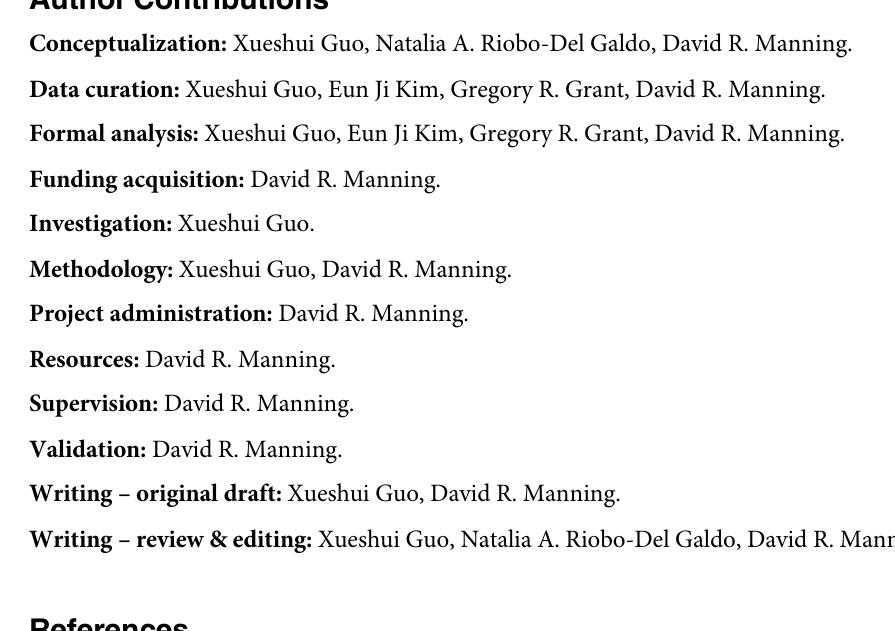
S1 Fig. Alkaline phosphatase expression as a function of purmorphamine concentration. S2 Fig. Few if any stress fibers exist in the absence of transduction. S3 Fig. Alkaline phosphatase activity following introduction of G α 13QL depends on the nature of the medium. S1 Table. Genes exhibiting the greatest -fold increases in transcripts following introduc- tion of SmoA1 and G α 13QL, relative to LacZ, in C3H10T1/2